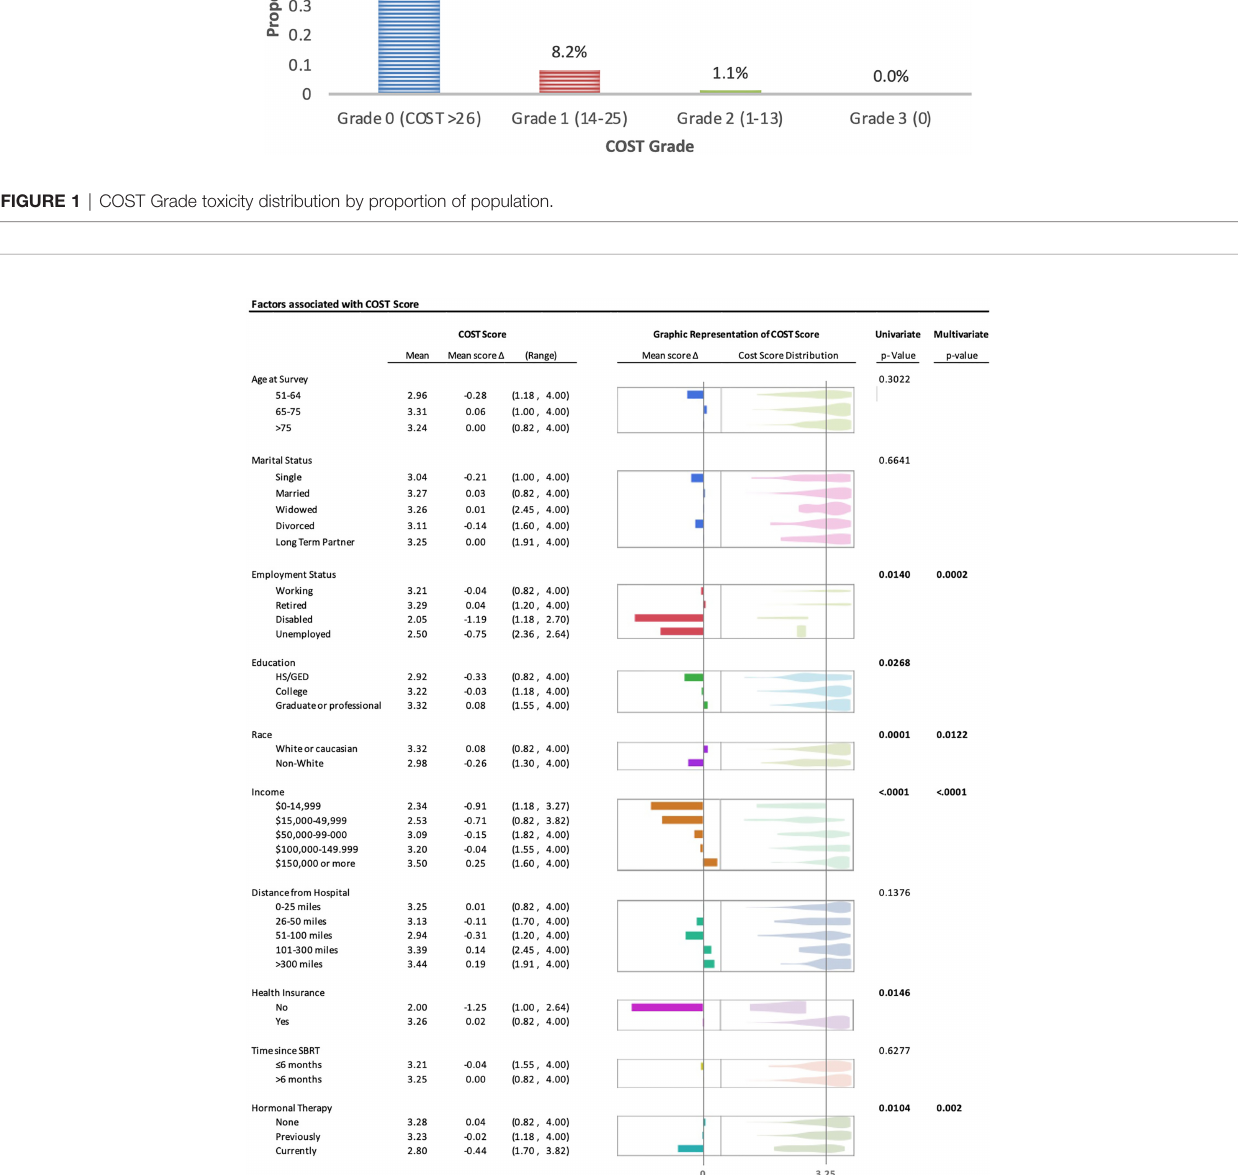
FIGURE 2 | UVA and MVA of covariates associated with greater fi nancial toxicity (COST Score). Mean COST Score, difference from population mean, and range in the fi rst column; graphic representation of difference in mean COST Score and violin plot showing the distribution of individual COST Score values; vertical line represents the population mean COST Score. p -value of univariate analysis using linear regression for age, and Wilcoxon rank-sum or Kruskal – Wallis test for remainder of variables; multivariate analysis using multiple regression with standard least-square